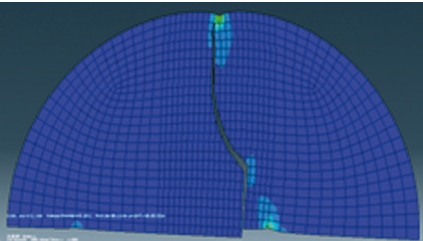
Figure 10: Distribution of stress and crack propagation path from XFEM.